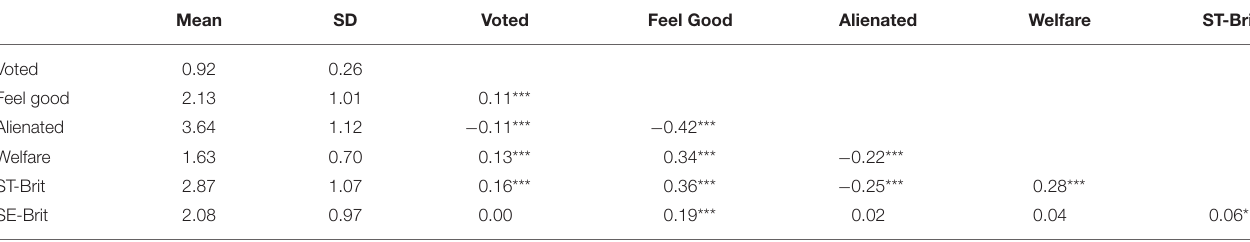
TABLE 1 | Correlations and descriptive statistics for Study 1